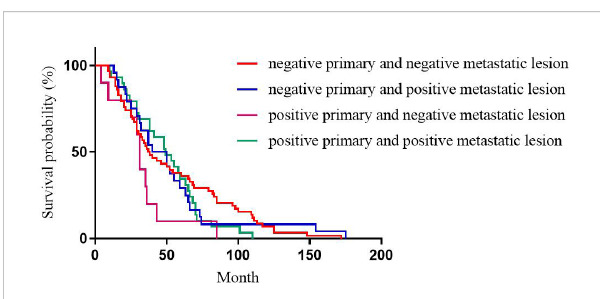
FIGURE 3 Correlation between HER2 expression heterogeneity and patient DFS.